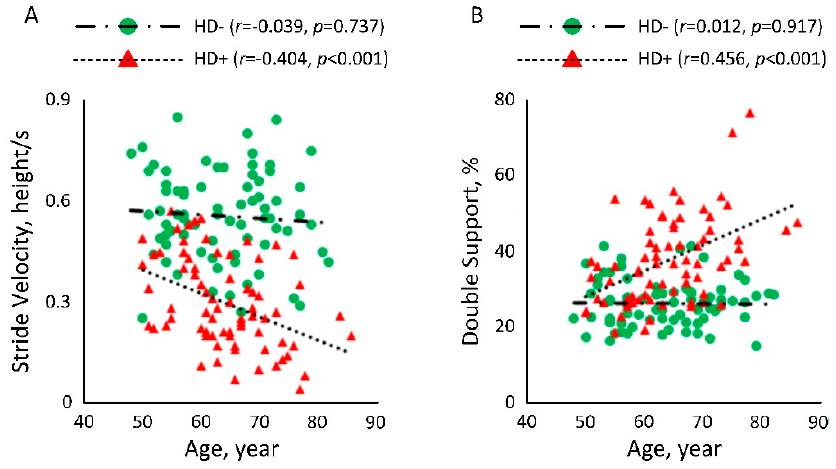
Figure 3. Correlation between age and ( A ) normalized stride velocity and ( B ) double support among people with diabetes with and without HD.